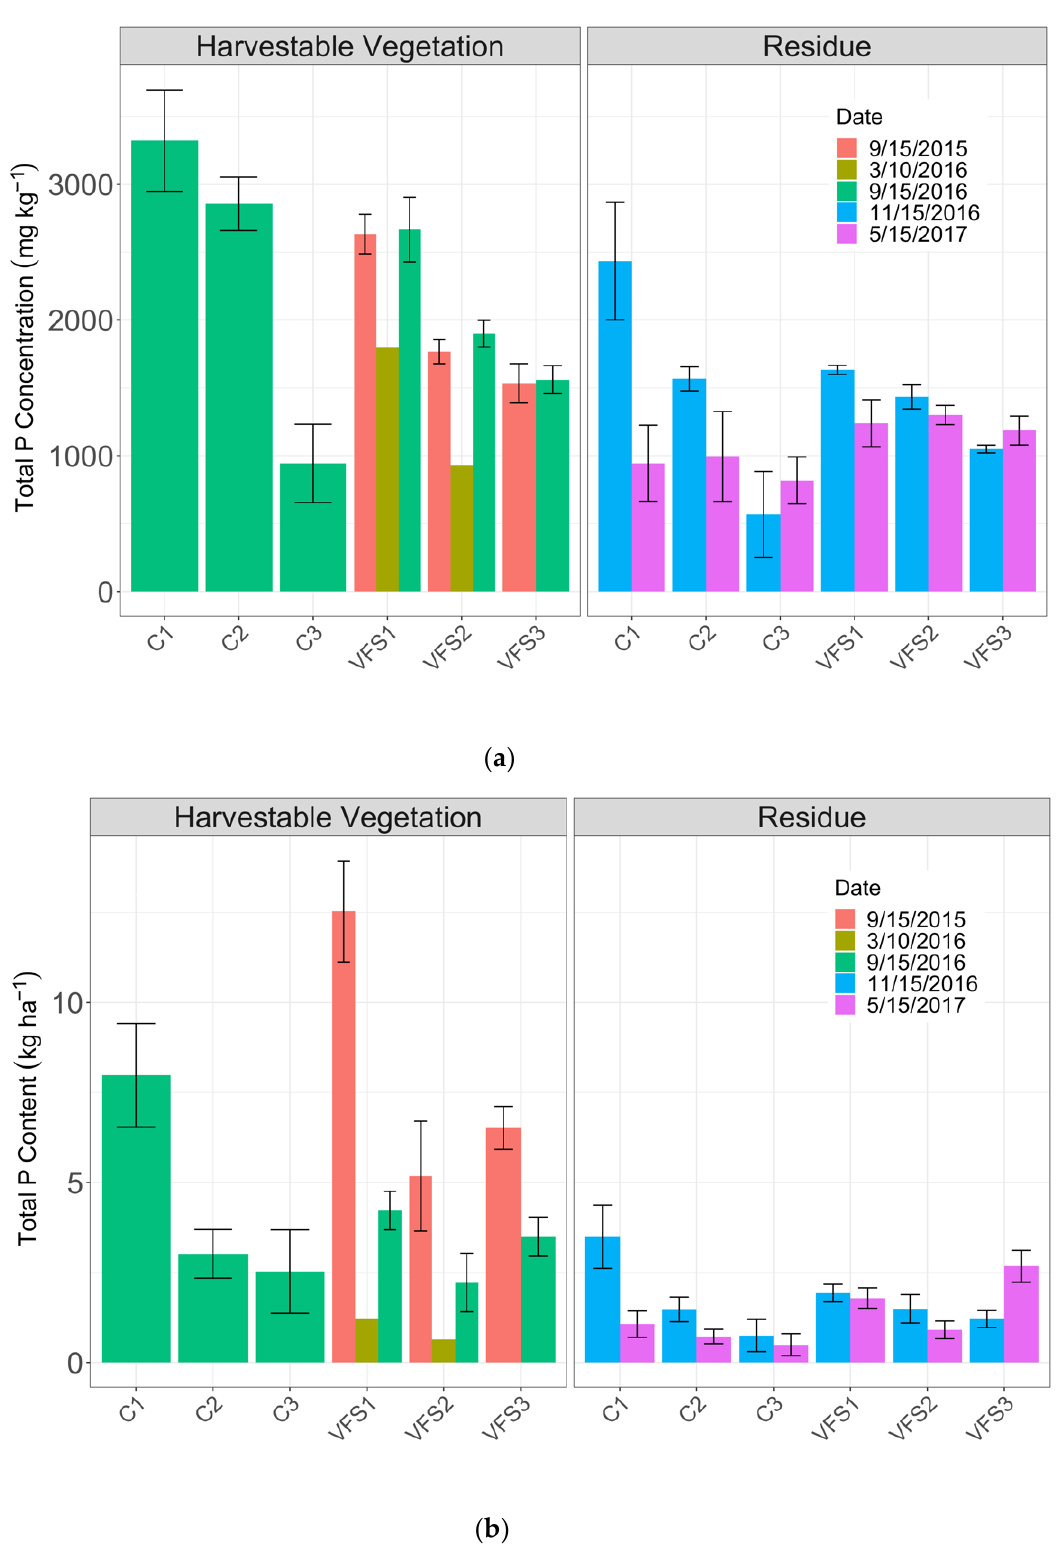
Figure 4. ( a ) Mean concentrations of TP (mg kg −1 ) and ( b ) TP (kg ha −1 ) in harvestable vegetation and residue samples. Error bars signify standard error.